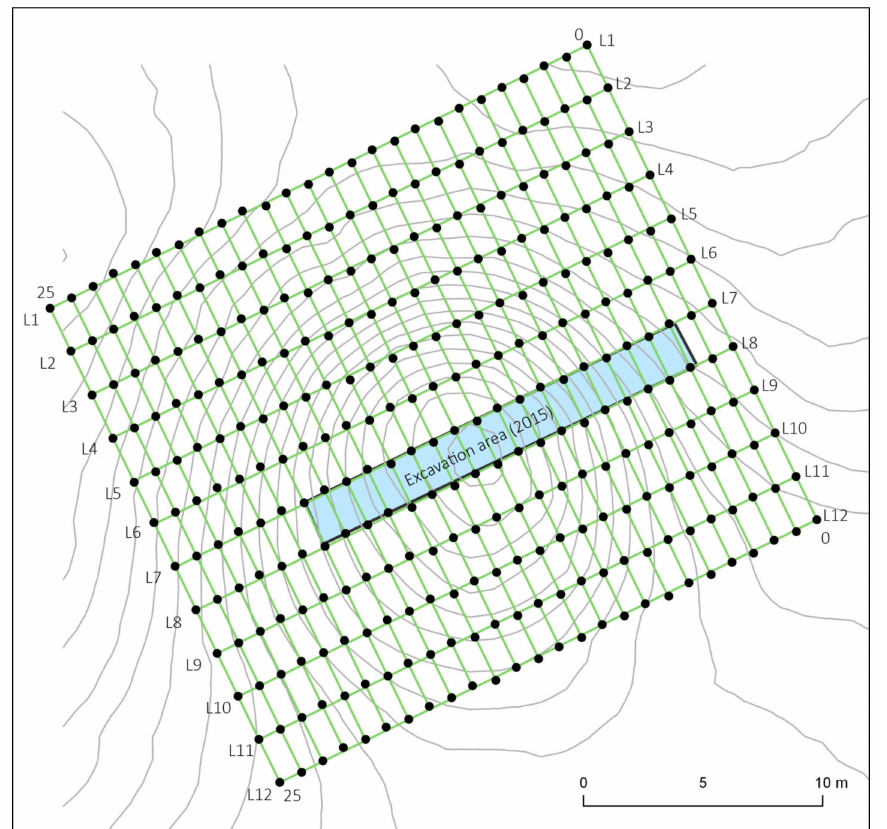
Figure 8. Position of each electrical resistivity tomography (ERT) electrode during the field